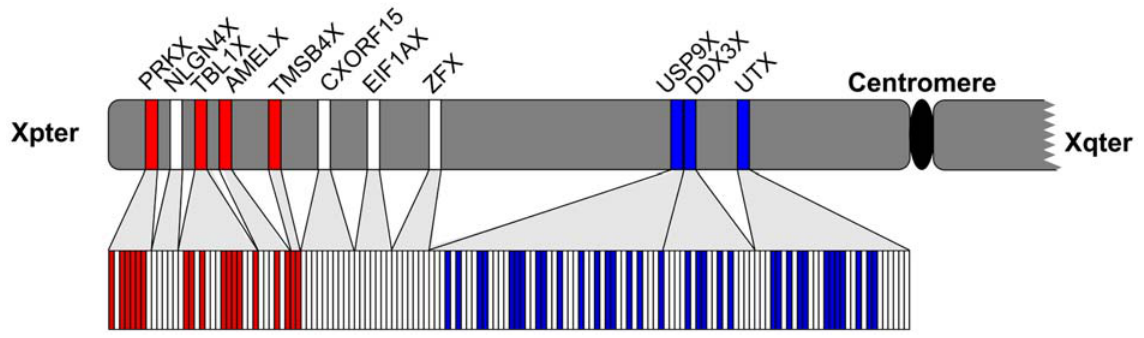
Figure 1. Phylogenetic analysis and branch length comparisons for concatenated gene sequences: gene-by-gene (upper panel) and exon-by-exon (lower panel) analysis. Xpter and Xqter—the termini of the short and long arms of the X chromosome, respectively. Red and blue boxes indicate the post- and pre-radiation topology, respectively, and white boxes represent masked out sequence (see Materials and Methods).